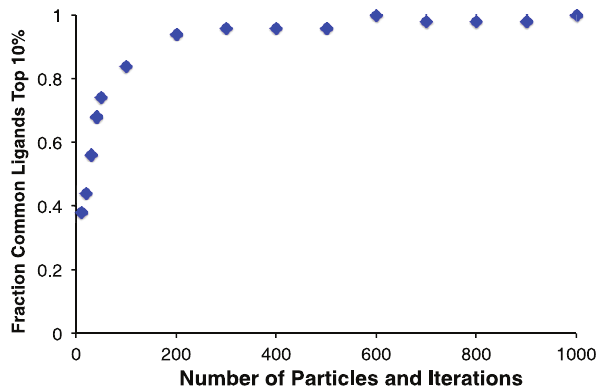
Figure 5. Effect of the number of particles and the number of iterations on the ‘‘hit’’ compounds selected. The most pragmatic measure of convergence is the identity of the ‘‘hits’’ to be advanced for further evaluation. The top scoring 10% of the compound library from the most extensive docking simulations were considered to be the ‘‘gold standard’’ hits. With increasing computationally intensive simulations (by together increasing the number of particles and the number of iterations), an increasing fraction of the hits are members of the ‘‘gold standard’’ set.